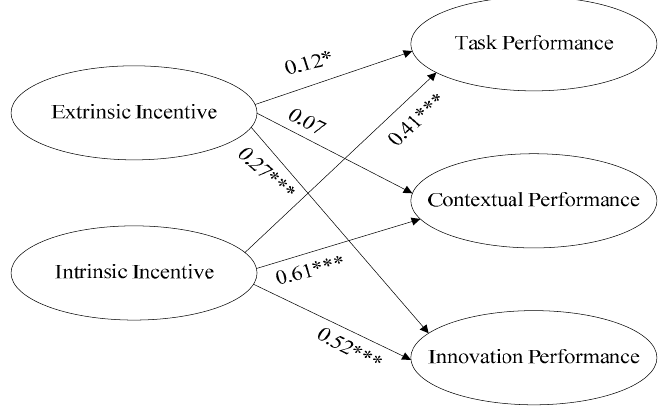
Figure 1. Testing result of influential effect of intrinsic-extrinsic incentive factors on performance. * p < 0.1; *** p < 0.01.